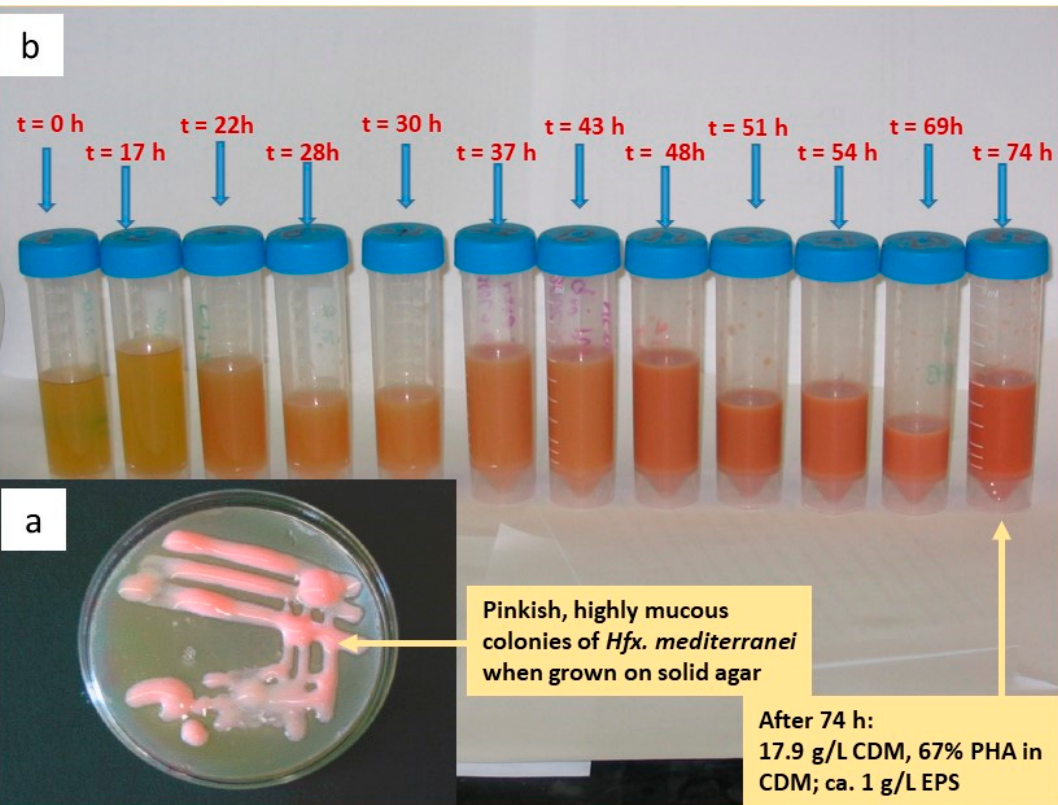
Figure 3. ( a ) Pinkish, mucous Hfx. mediterranei colonies grown on solid medium. ( b ) Macroscopic